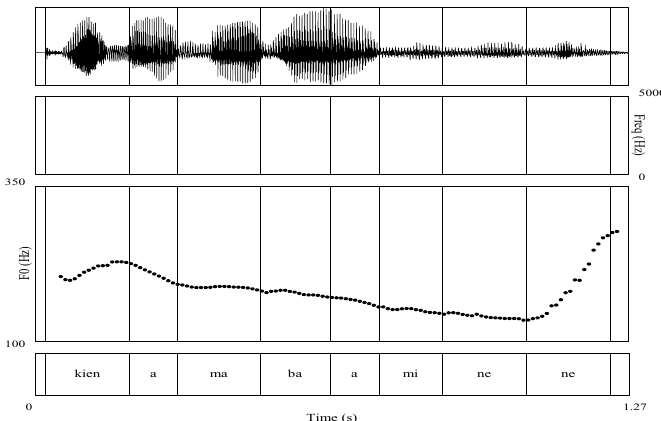
Figure 6. Waveform, spectrogram, and F0 (final rise, ultimate syllable) contour for ¿Quién amaba a mi nene? (Who was loving my boy?). F0 contour divided according to syllable